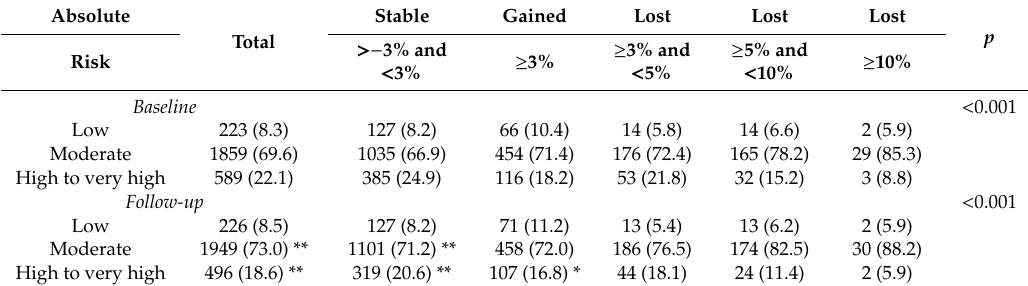
Table 4. Changes in ten-year absolute risk of fatal CVD from baseline to two-year follow-up, as stratified by Systematic Coronary Risk Evaluation (SCORE) and weight change categories,